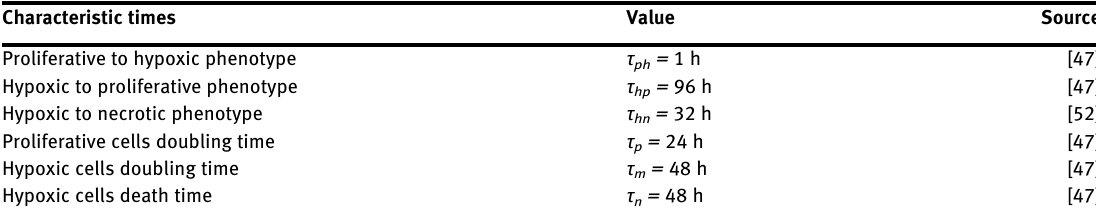
Table  : Proliferation and phenotype transition